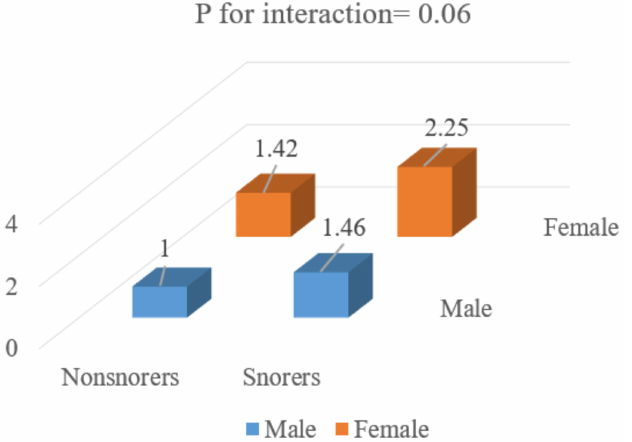
Figure 3. ORs for MetS according to gender and snoring status. ORs according to joint classification were adjusted for age, sleep duration, exercise, eGFR and current smoking and drinking